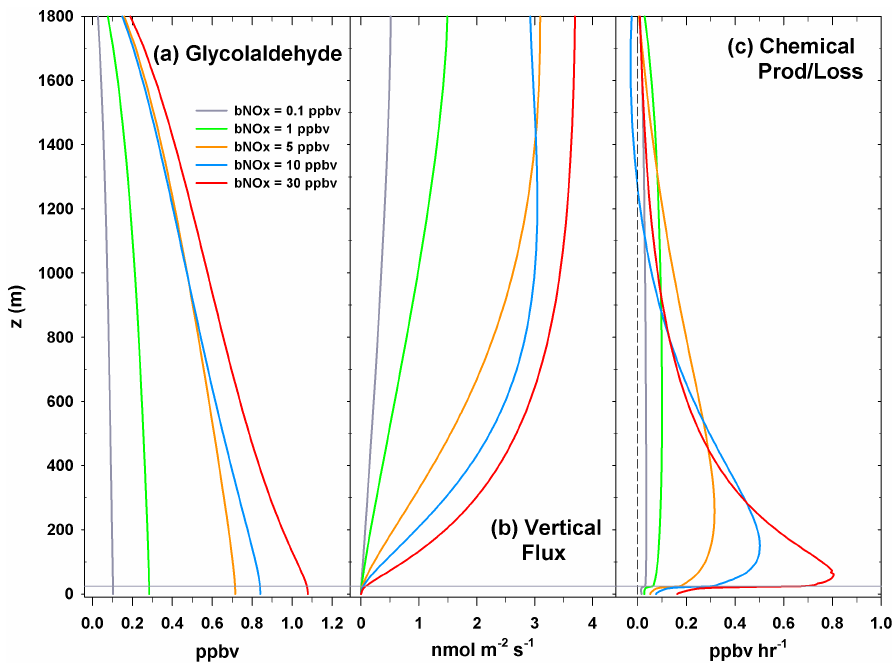
Fig. 13. Vertical profiles of glycolaldehyde (a) mixing ratio (ppbv), (b) vertical flux (nmolm − 2 s − 1 ) , and (c) chemical production or loss (ppbvh − 1 ) for each background NO x value (horizontal gray line is canopy top height).